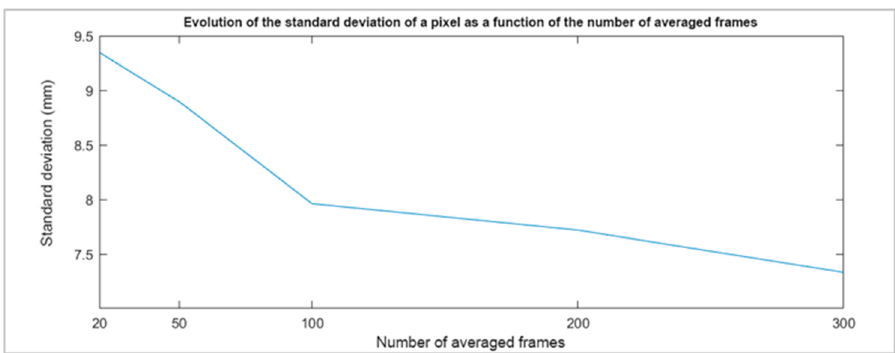
Figure 9. Evolution of the standard deviation of a pixel as a function of the number of averaged